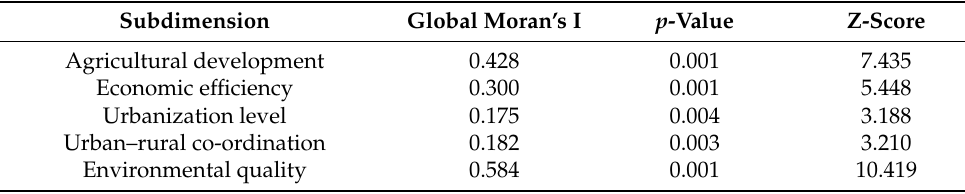
Figure 3. Spatial distribution of the subdimensional quality of MGPAs in 2018. Table 6. Moran’s I of subdimensions in